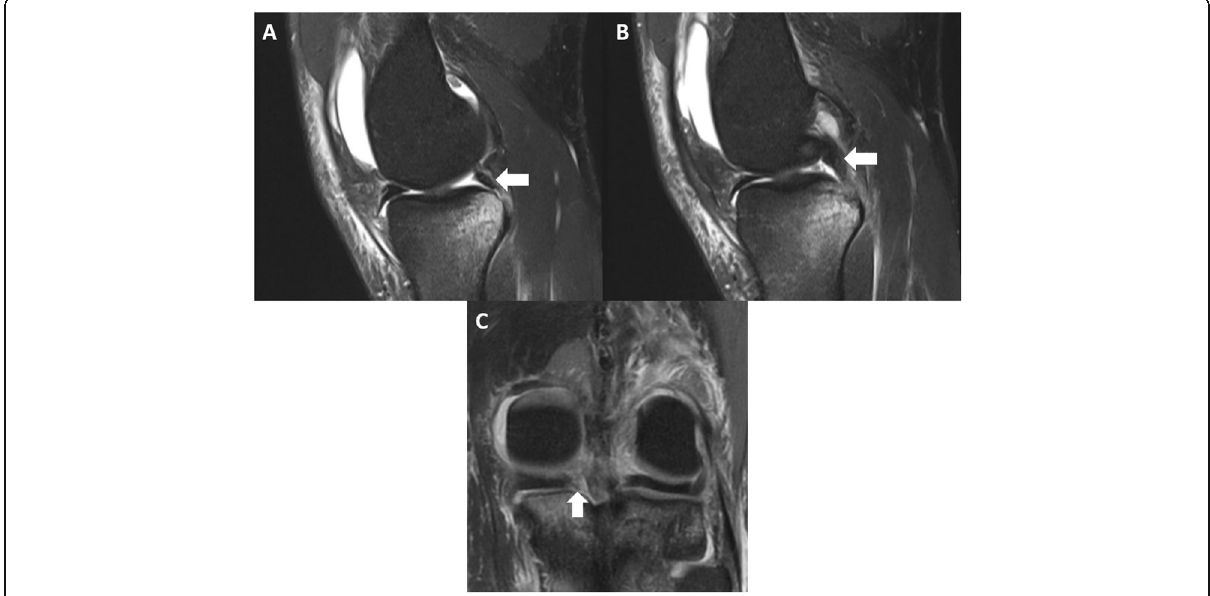
Fig. 2 A magnetic resonance imaging of a medial meniscus root tear in conjunction with an anterior cruciate ligament tear. The white arrows point to the meniscus root as it enters its insertion on the tibia. On the top images ( a and b ), there is fluid underneath the root with no clear attachment to the tibia. The bottom image ( c ) demonstrates no clear attachment of the root to the